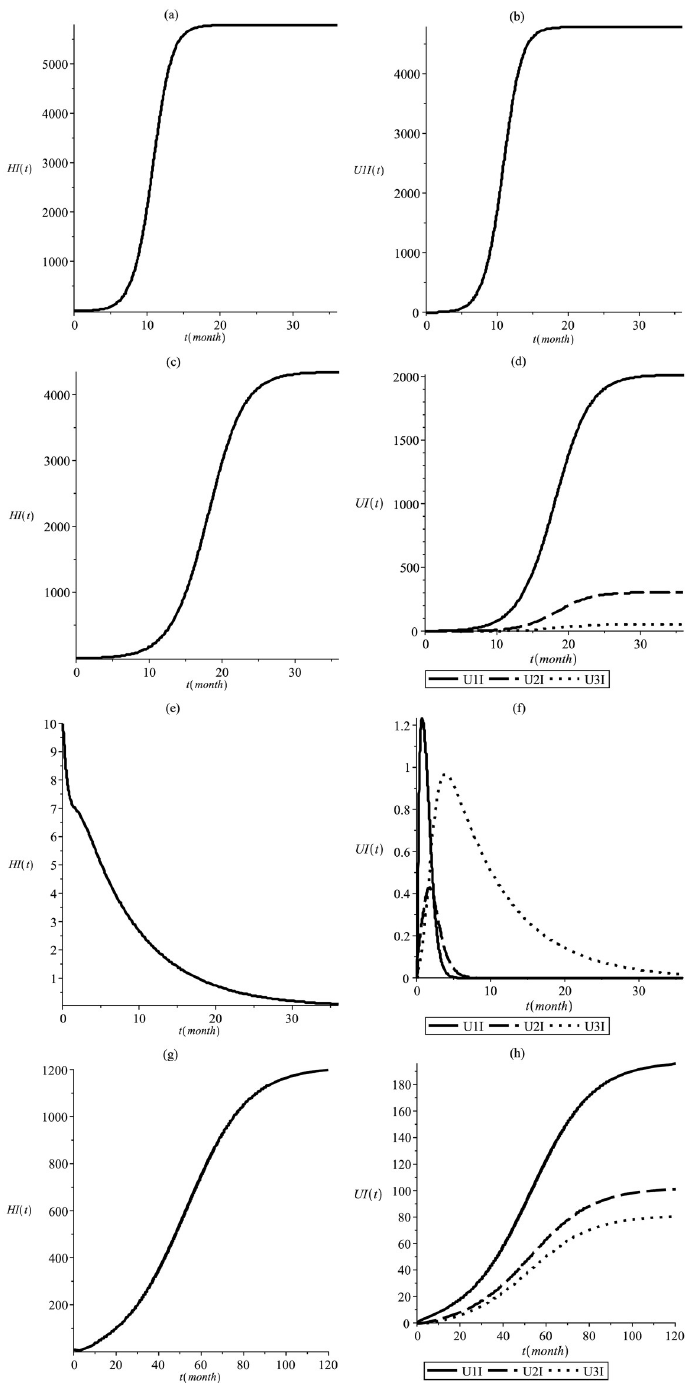
Fig 7. This simulation shows the infectious dynamics at T = 32˚C and p 1 = 0.3, p 2 = 0.4, p 3 = 0.3. Infectious human (a) and wild mosquitoes (b) in the absense of transgenic, resulting in R 0 = 3.44; infectious human (c) and mosquitoes (d) considering Mendelian inheritance and resulting in R Mend = 2.19; infectious human (e) and mosquitoes (f) considering MCR inheritance and without fitness cost resulting in R = 0.69; infectious human (g) and mosquitoes MCR (h) considering MCR inheritance and fitness cost resulting in R MCR =